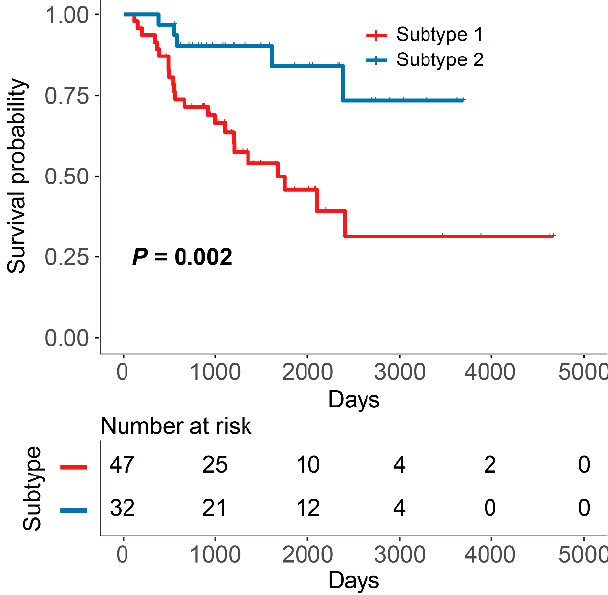
Figure 5 . KM curves for OS of patients with subtypes 1 and 2. Figure 5. KM curves for OS of patients with subtypes 1 and